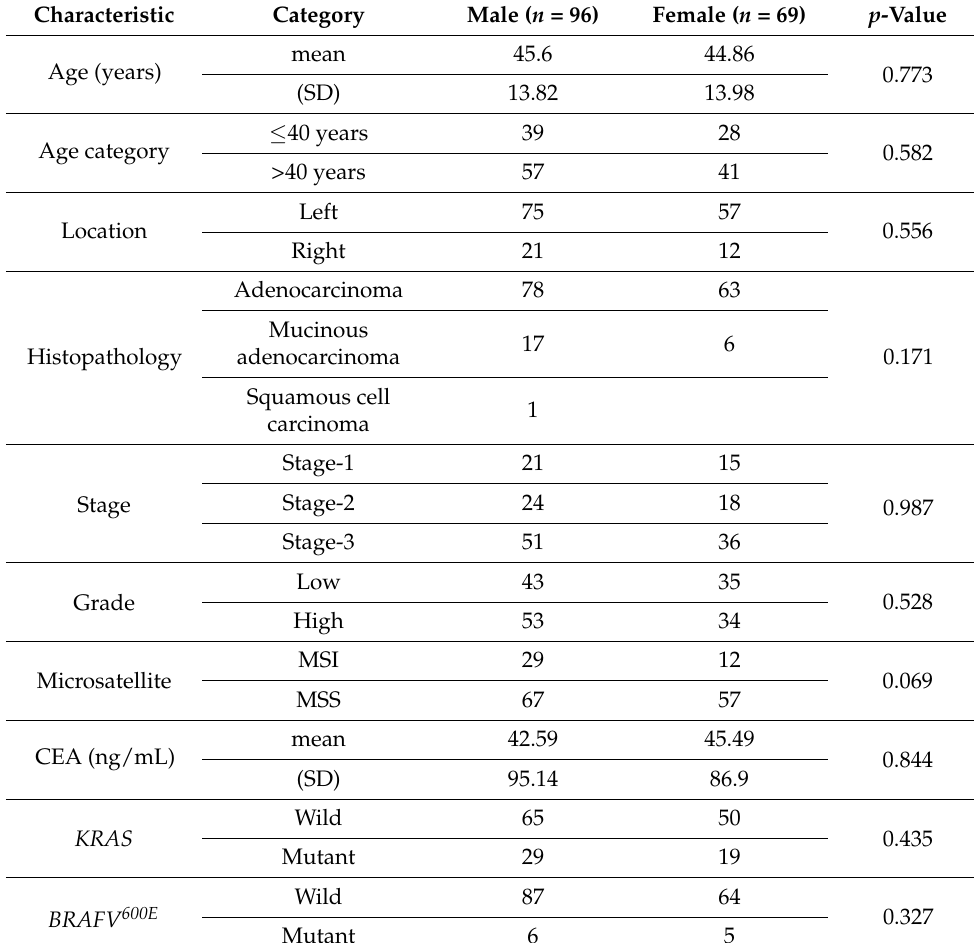
Table 1. Characteristics of the 165 CRC